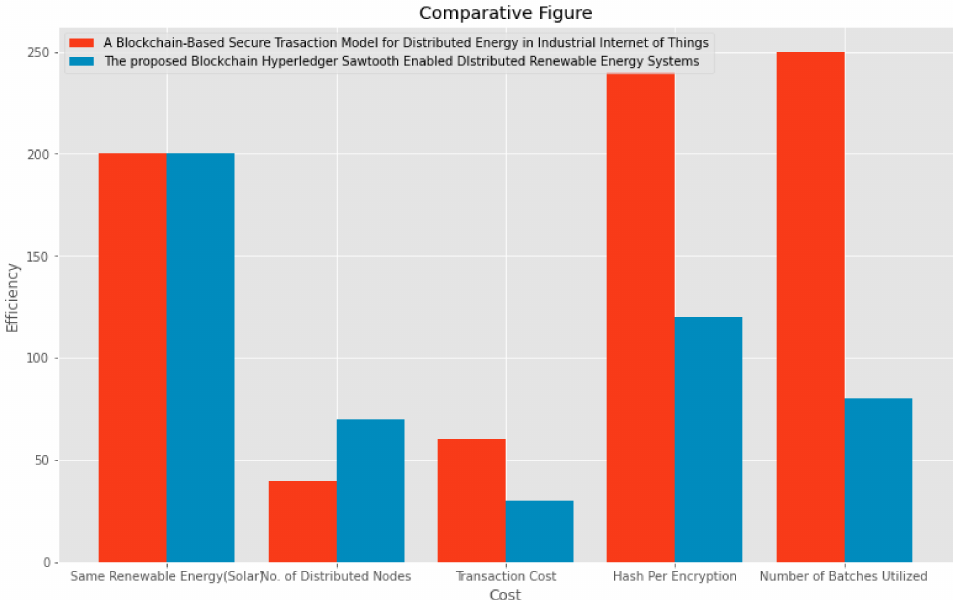
Figure 12. Comparison of the proposed architecture with other state-of-the-art methods.